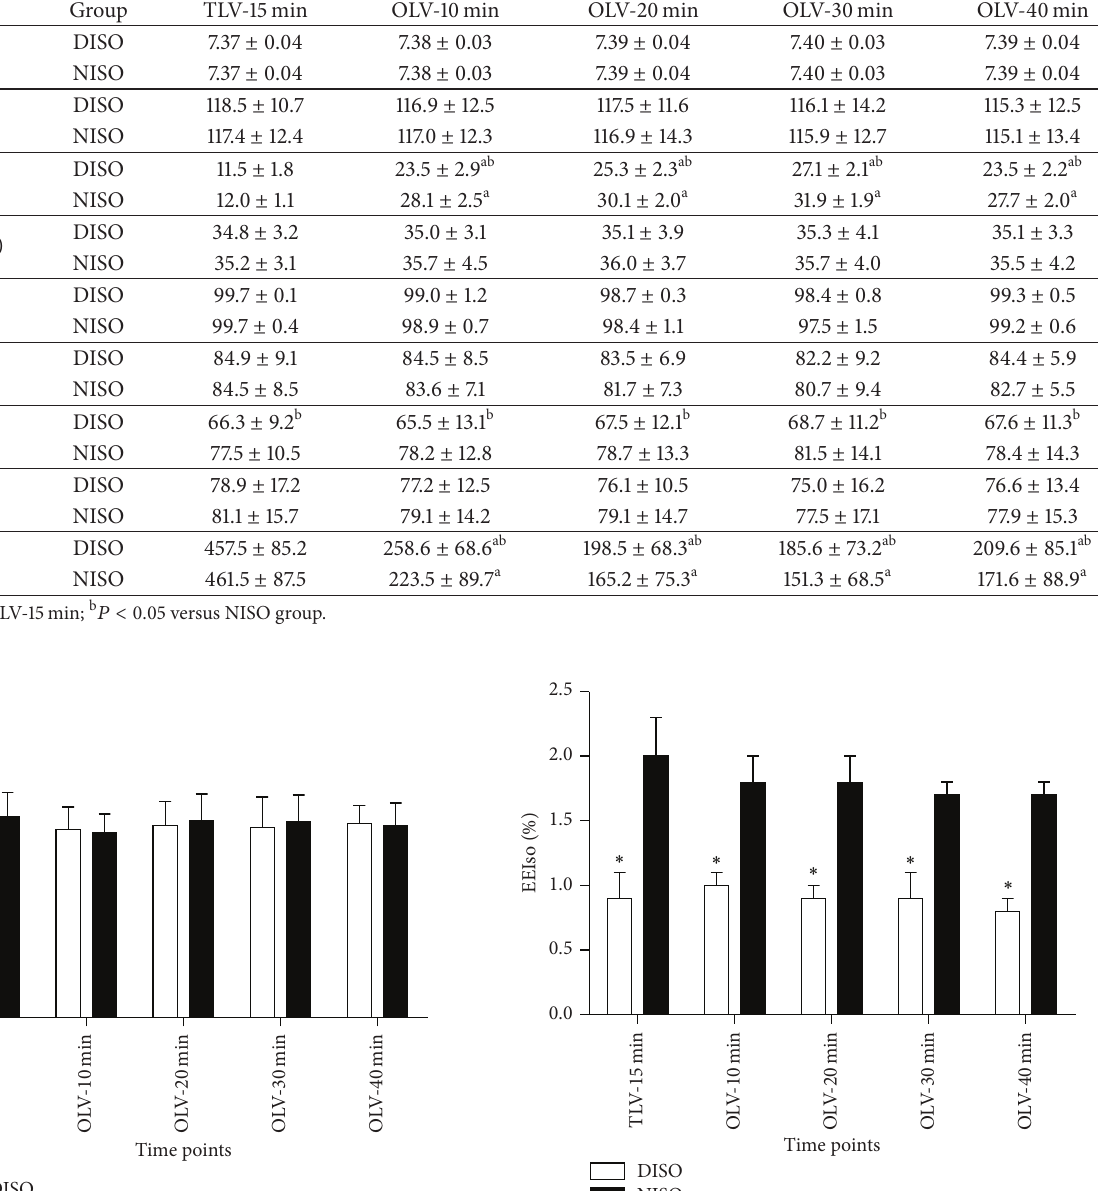
Table 2: Perioperative time-course changes of blood gas variables in DISO group ( 𝑛 = 25) and NISO group ( 𝑛 = 24) ( 𝑥 ± 𝑠 ). Parameters